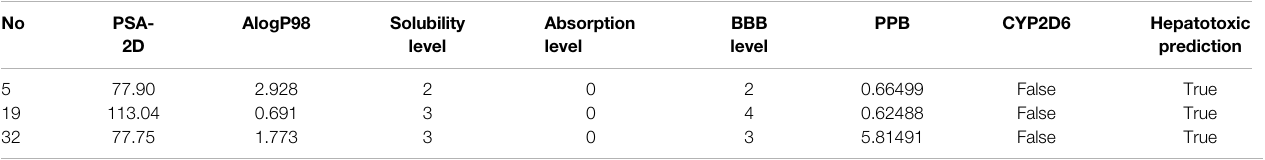
TABLE 3 | Prediction of ADMET properties of the identi fi ed